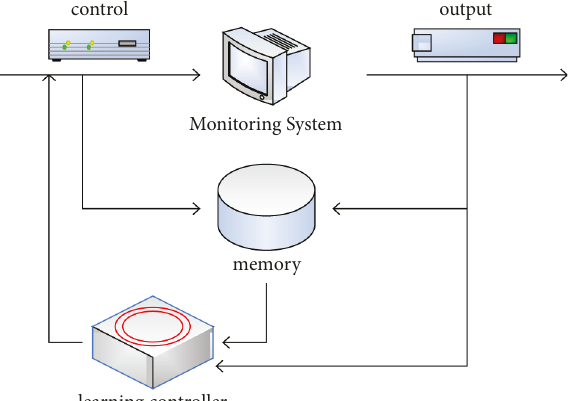
Figure 1: Principles of learning-controlled robotics. Table 1: Calculation basis of each parameter. Sequence Parameter Calculation